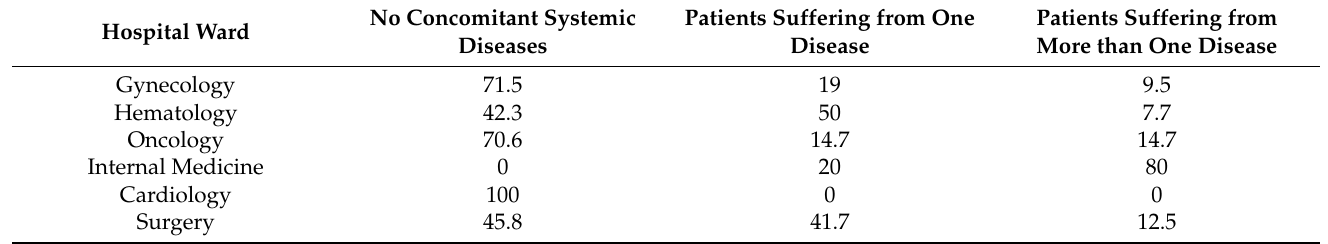
Table 2. Presence or absence of one or more diseases for patients in each hospital ward (percentages).